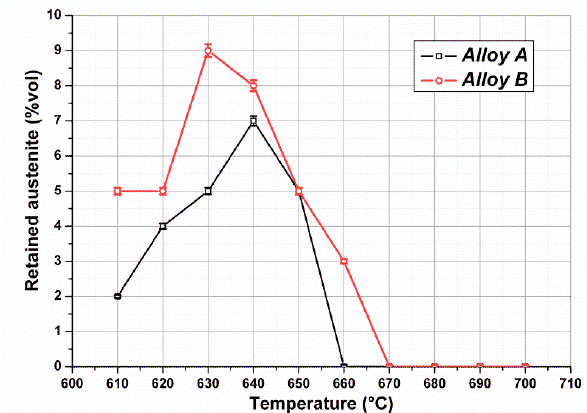
Figure 8. Volume fraction of retained austenite in function of tempering temperatures.